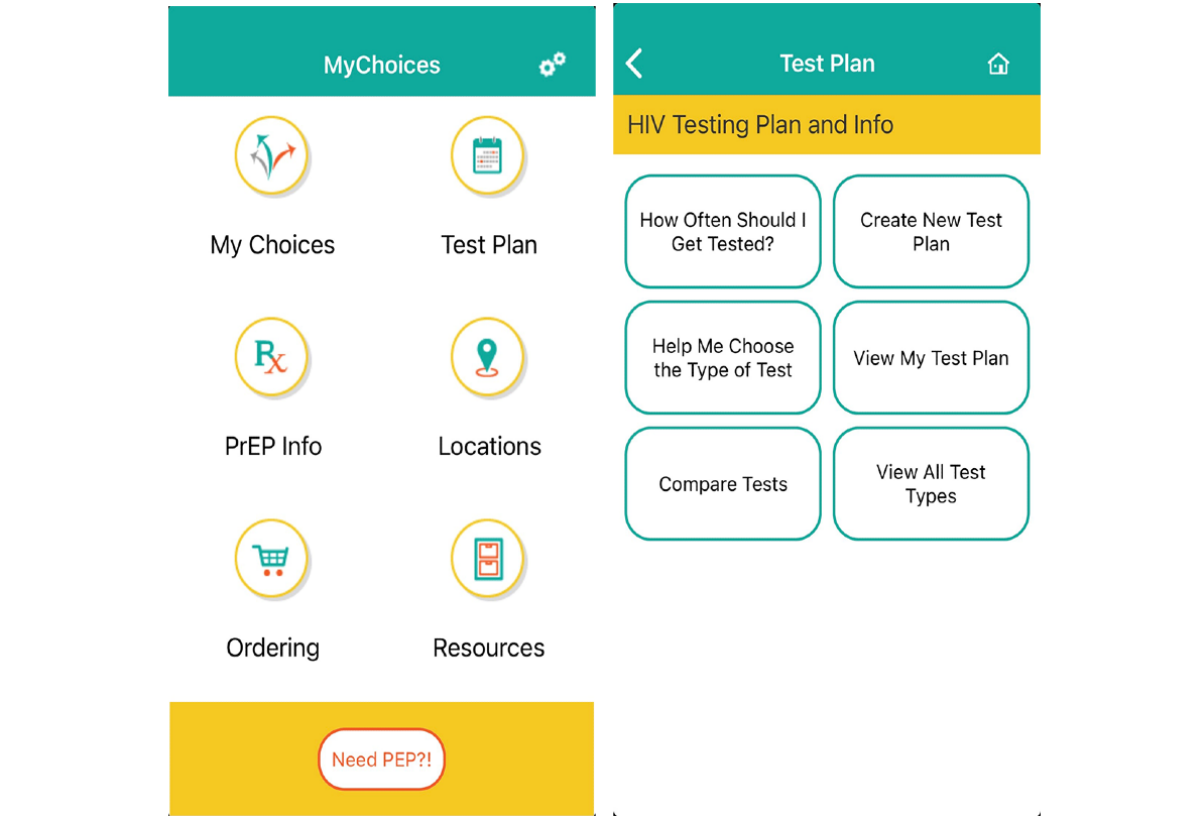
Figure 1. MyChoices app